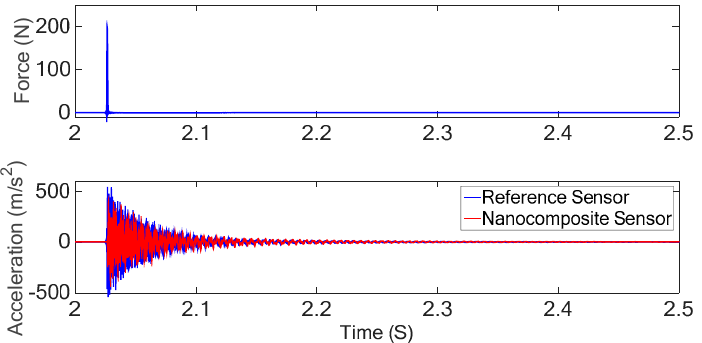
Figure 15. Time ‐ domain response of the piezoelectric hammer ( top ), and nanocomposite sensor and accelerometer responses under impulse excitation ( bottom ).